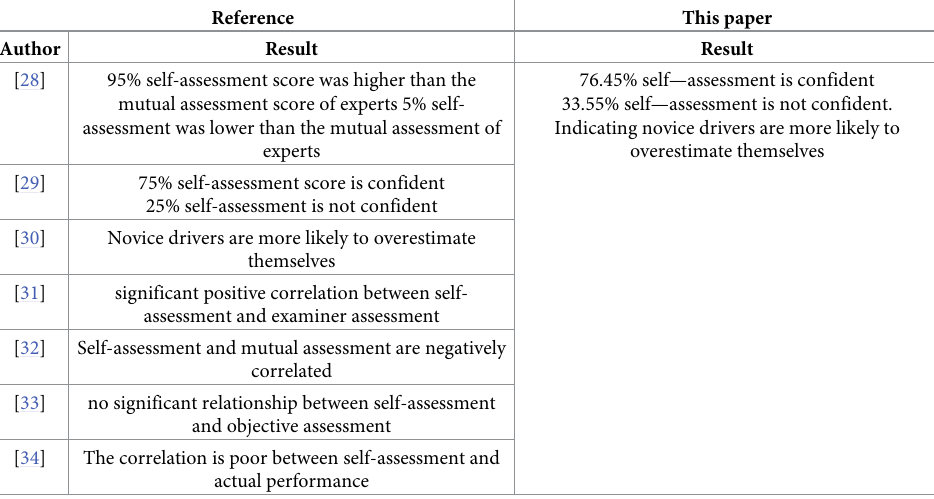
Table 11. Meta-analyses of cognitive bias between self-assessment and mutual